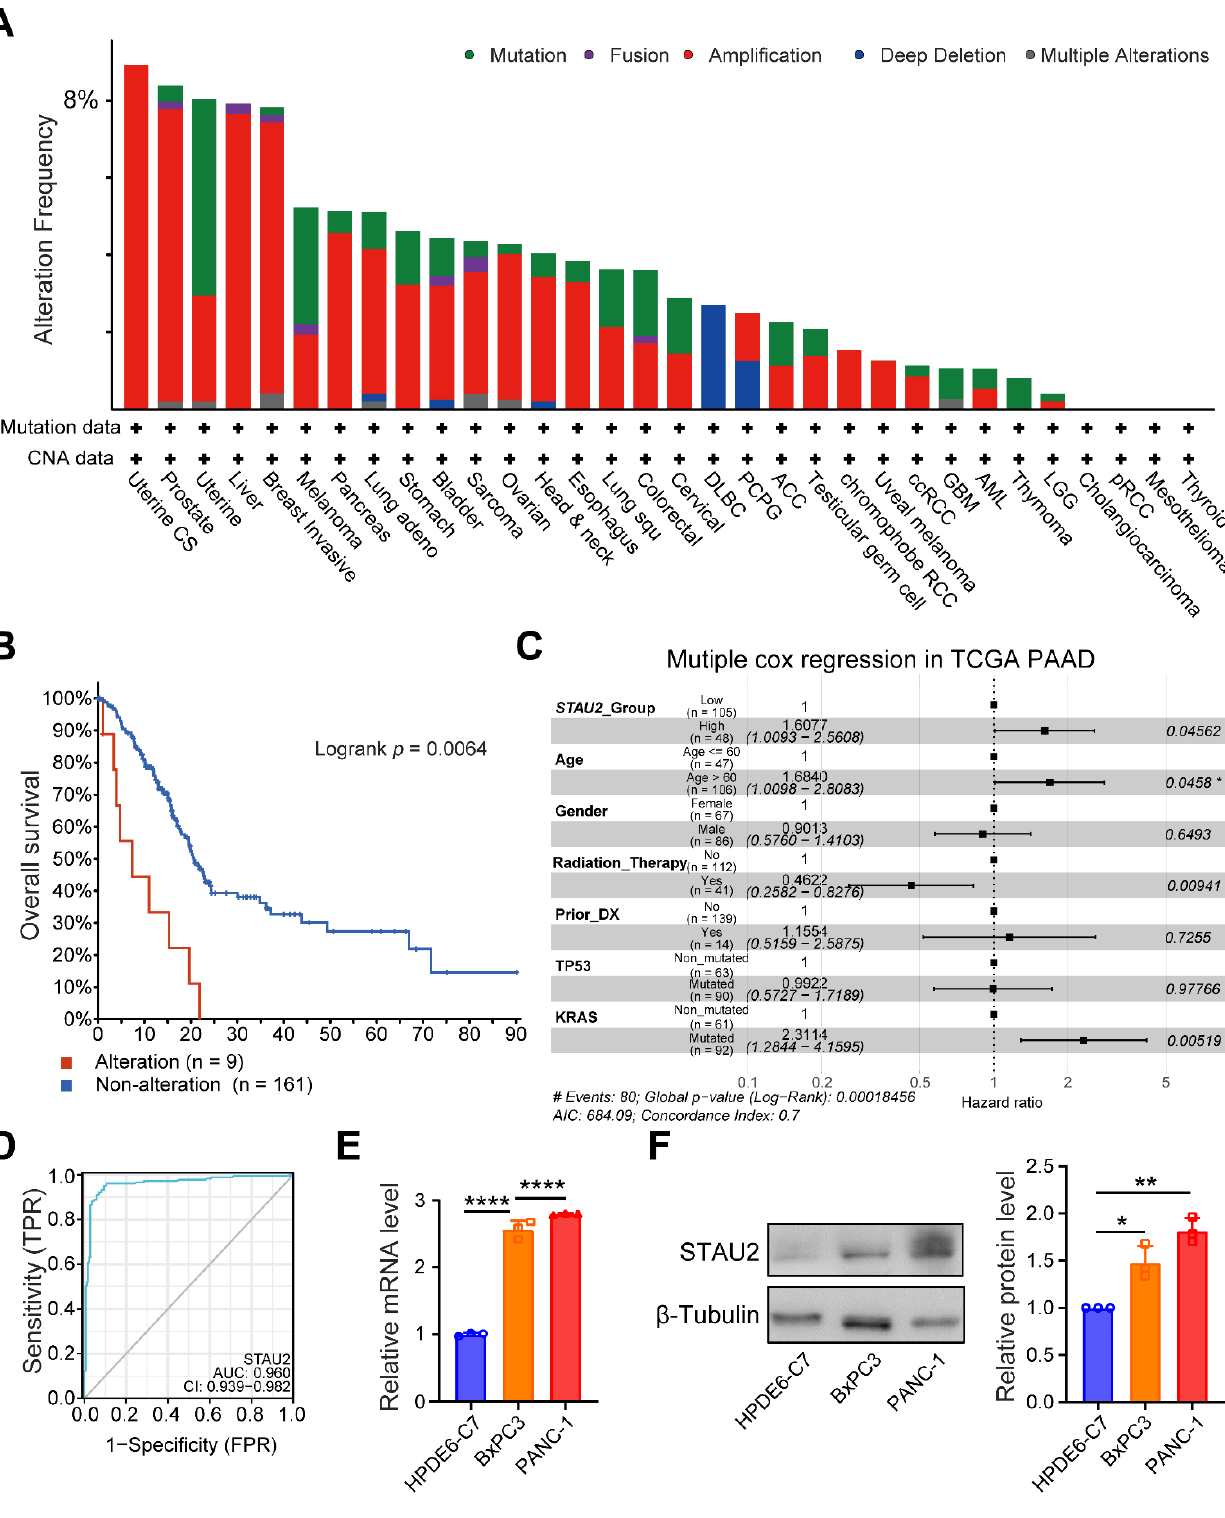
Figure 4. High expression of STAU2 correlates with prognosis in PAAD. ( A ) Bar plots to show the genetic alteration frequency of STAU2 among multiple tumors in TCGA. ( B ) Kaplan–Meier plots show overall survival in STAU2 alteration or non-alteration patients. ( C ) Forest plot showing the hazard ratios of multivariate Cox regression of TCGA in PAAD patients. ( D ) The receiver operating characteristic curve (ROC) predicts the accuracy of STAU2 as a diagnostic factor for pancreatic adenocarcinoma. ( E ) RT-qPCR experiment to show expression of STAU2 in HPDE6-C7, BXPC-3, and PANC-1. Statistical analysis of the results of three independent experiments was performed using